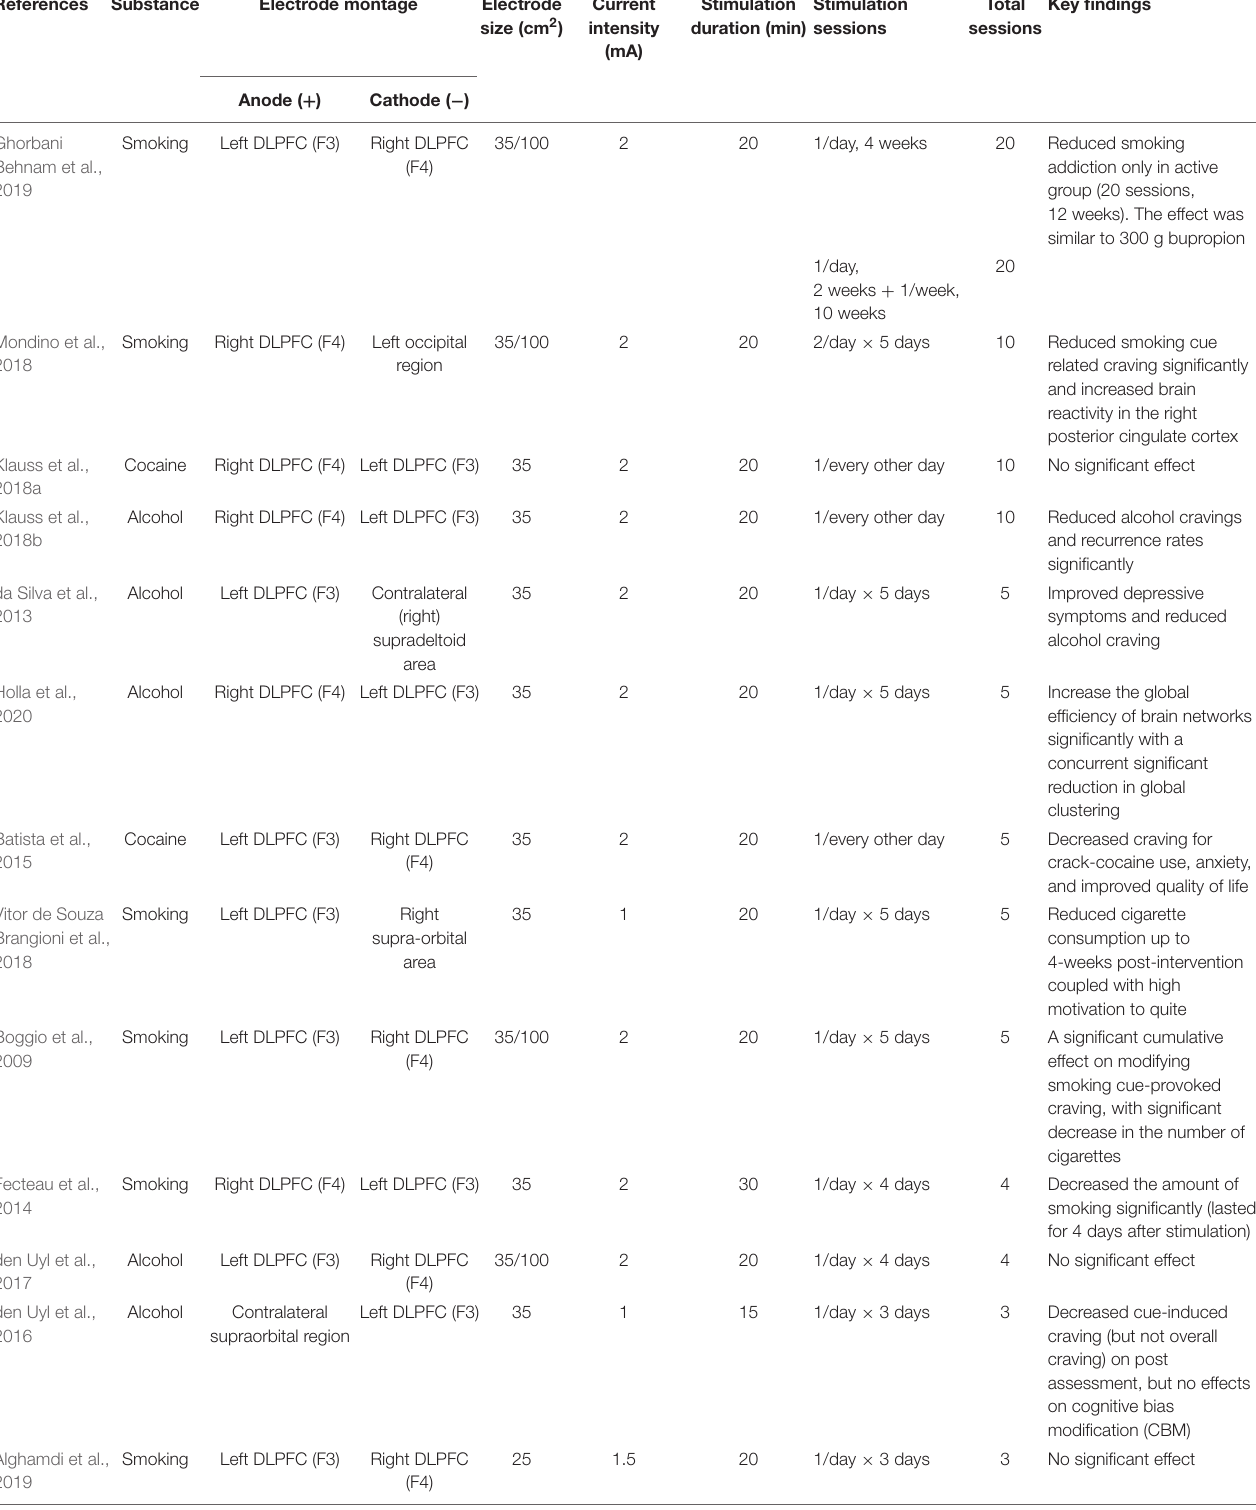
TABLE 3 | Effects of DLPFC tDCS on addiction